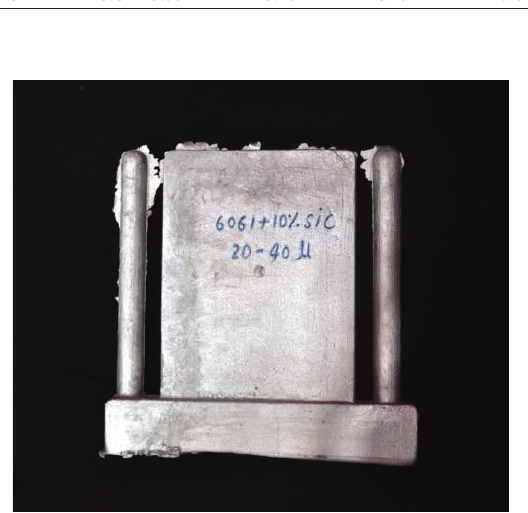
Figure 1: Al / SiC